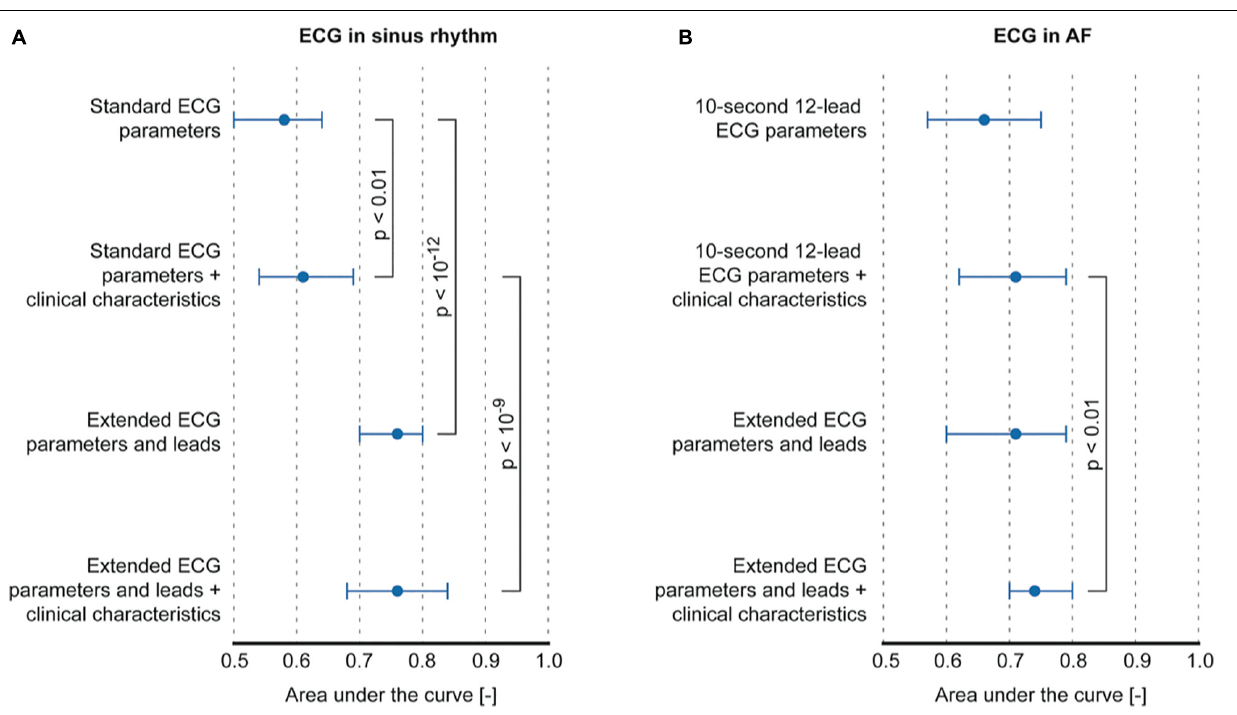
FIGURE 3 | Classification performance of models using P-wave or f-wave features. (A) Comparison of classification performance between standard ECG parameters and extended ECG P-wave parameters and leads, with and without controlling for clinical characteristics. (B) Comparison between classification performance of f-wave parameters that can be computed on a 10-s 12-lead ECG vs. parameters that can be computed on the extended